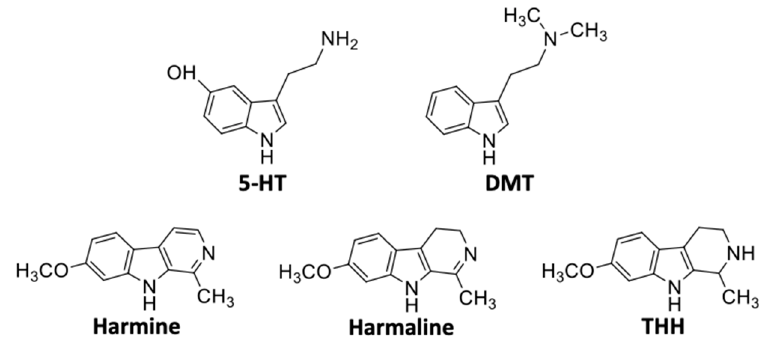
Figure 2. Chemical structure of serotonin (5-HT) and the main active alkaloids present in